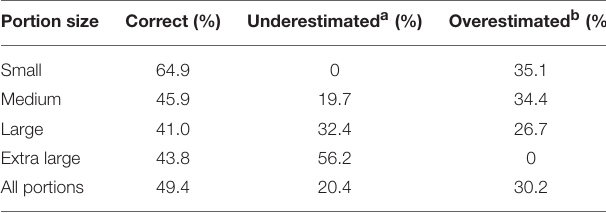
TABLE 3 | Proportion of correct responses and direction of errors for the estimation of portion sizes in the total